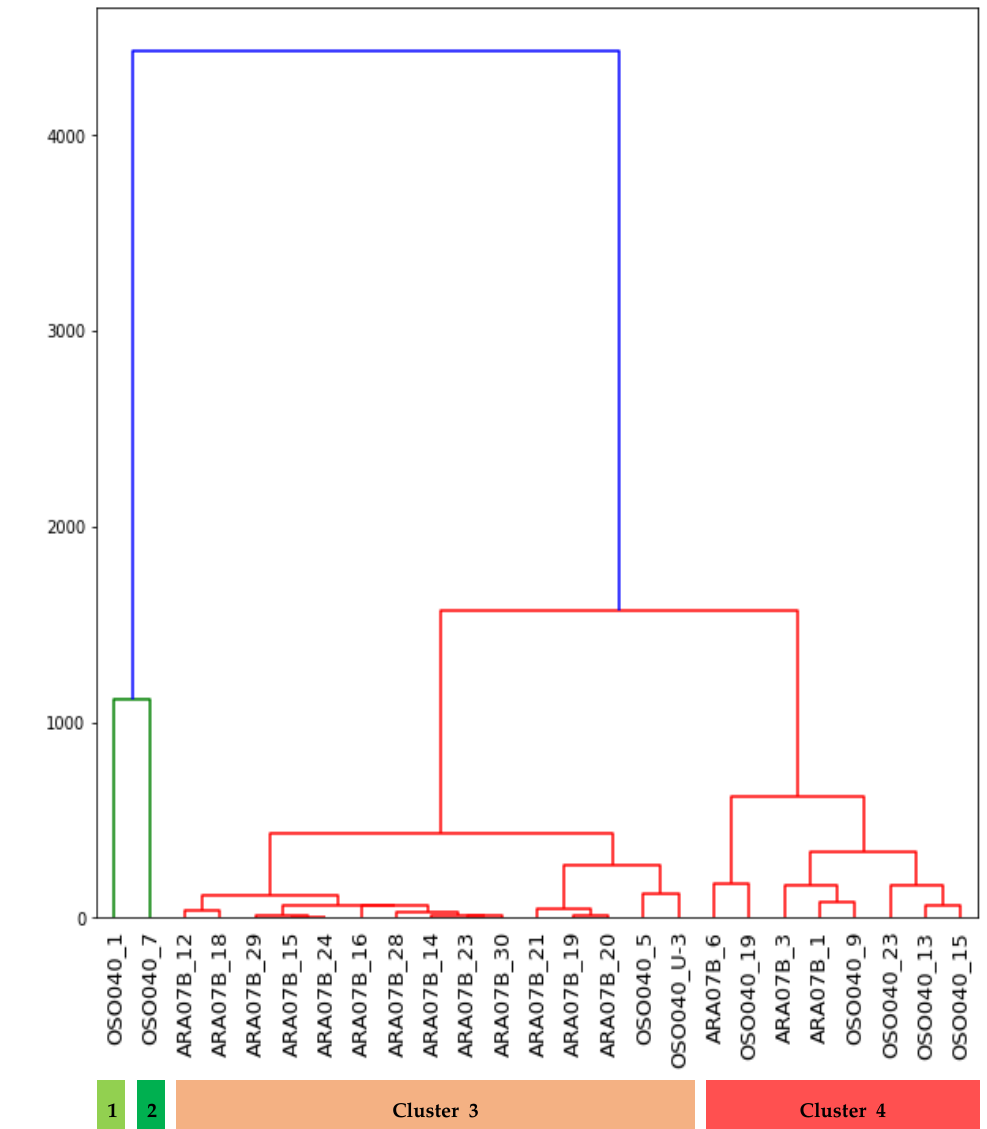
Figure 10. Dendrogram stands for sampling stations were divided into four clusters by agglomerative hierarchical clustering (AHC).